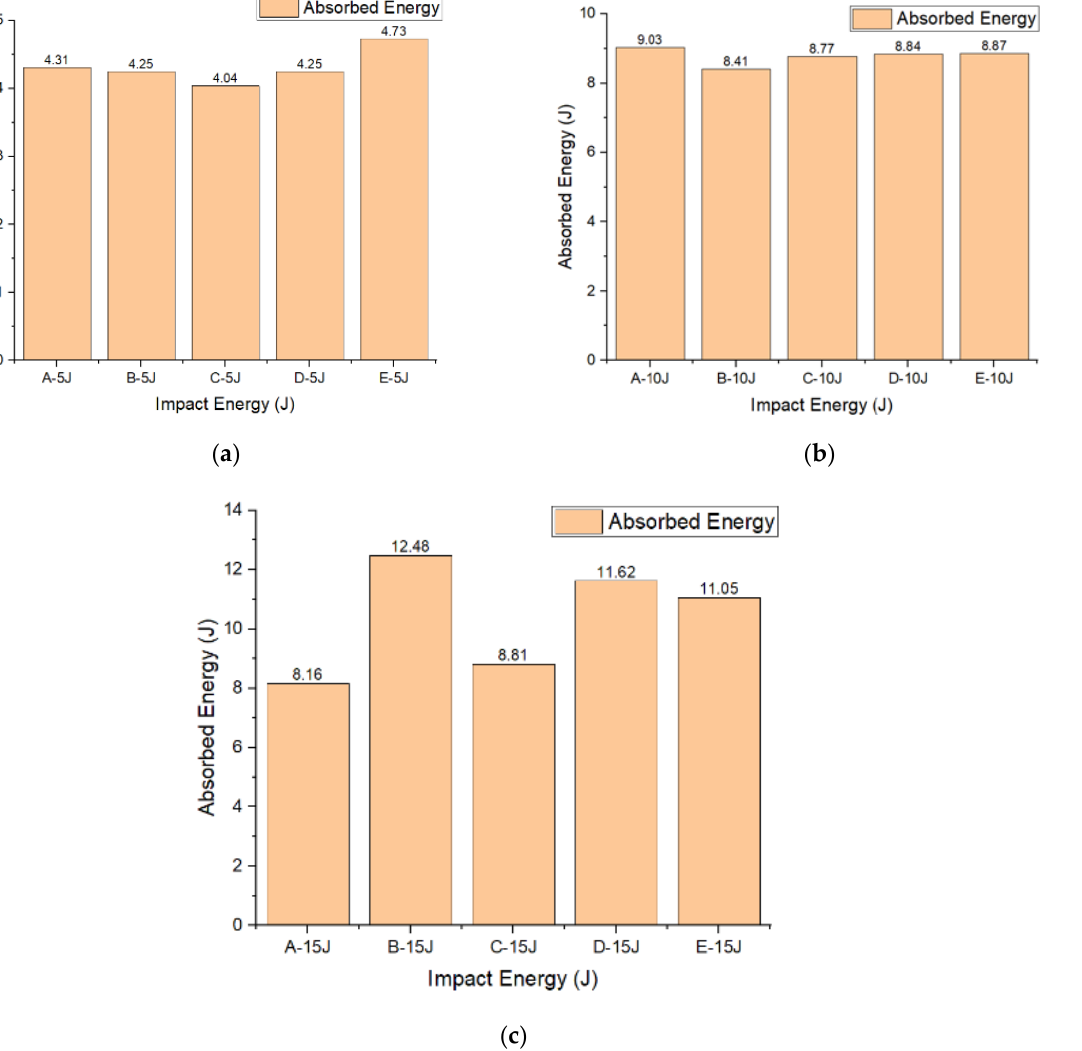
Figure 7. Energy absorption graph of 3D integrated woven spacer sandwich composites under impact energies ( a ) 5 J, ( b ) 10 J, and ( c ) 15 J.